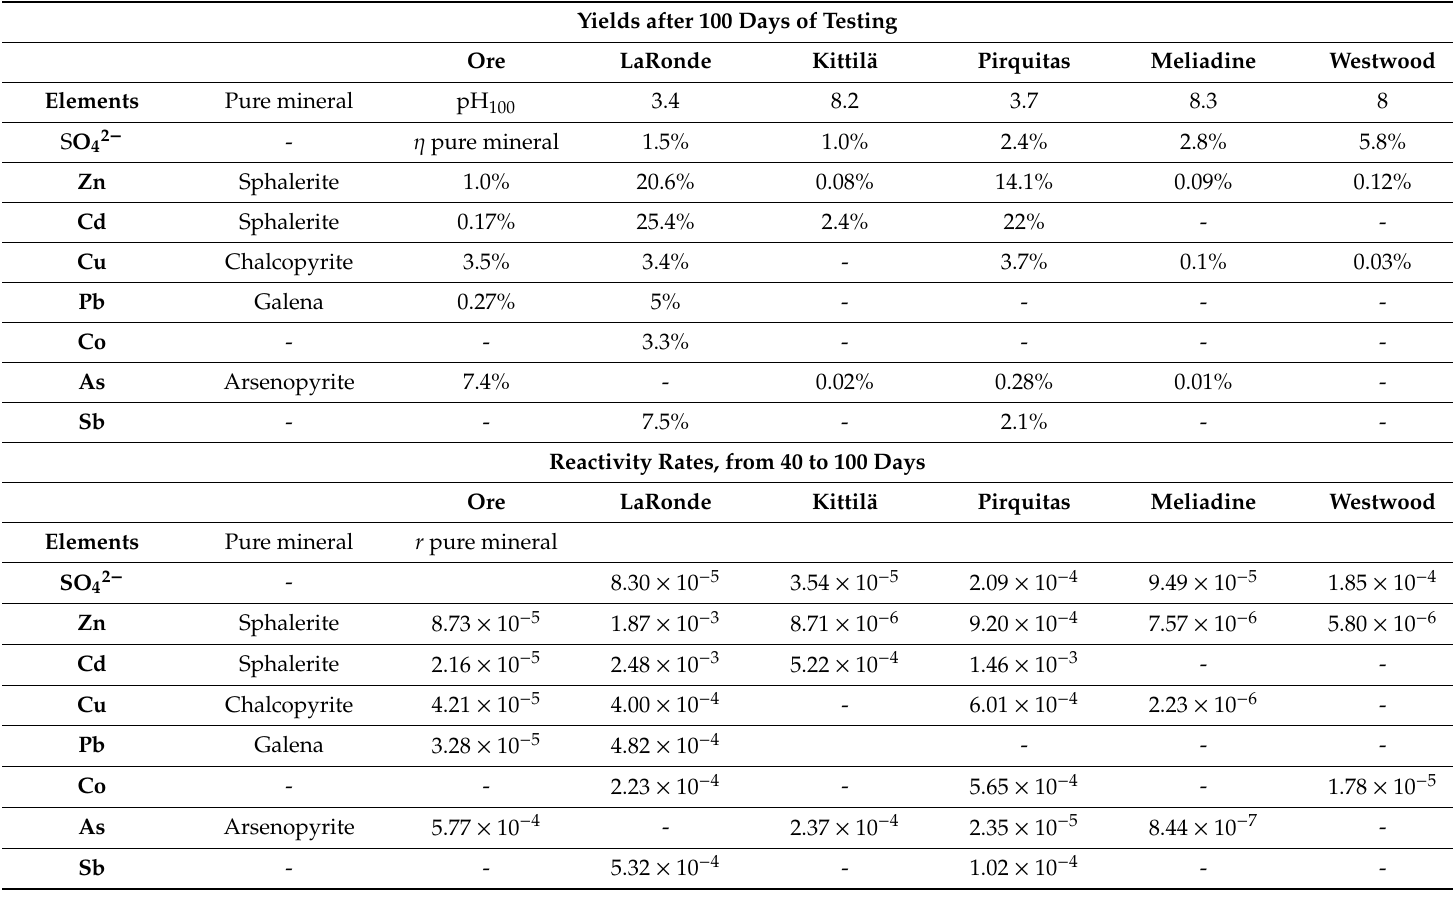
Table 5. Geochemical parameters of the LaRonde, Kittilä, Pirquitas, Meliadine, and Westwood samples, and pure samples of sphalerite, chalcopyrite, galena, and